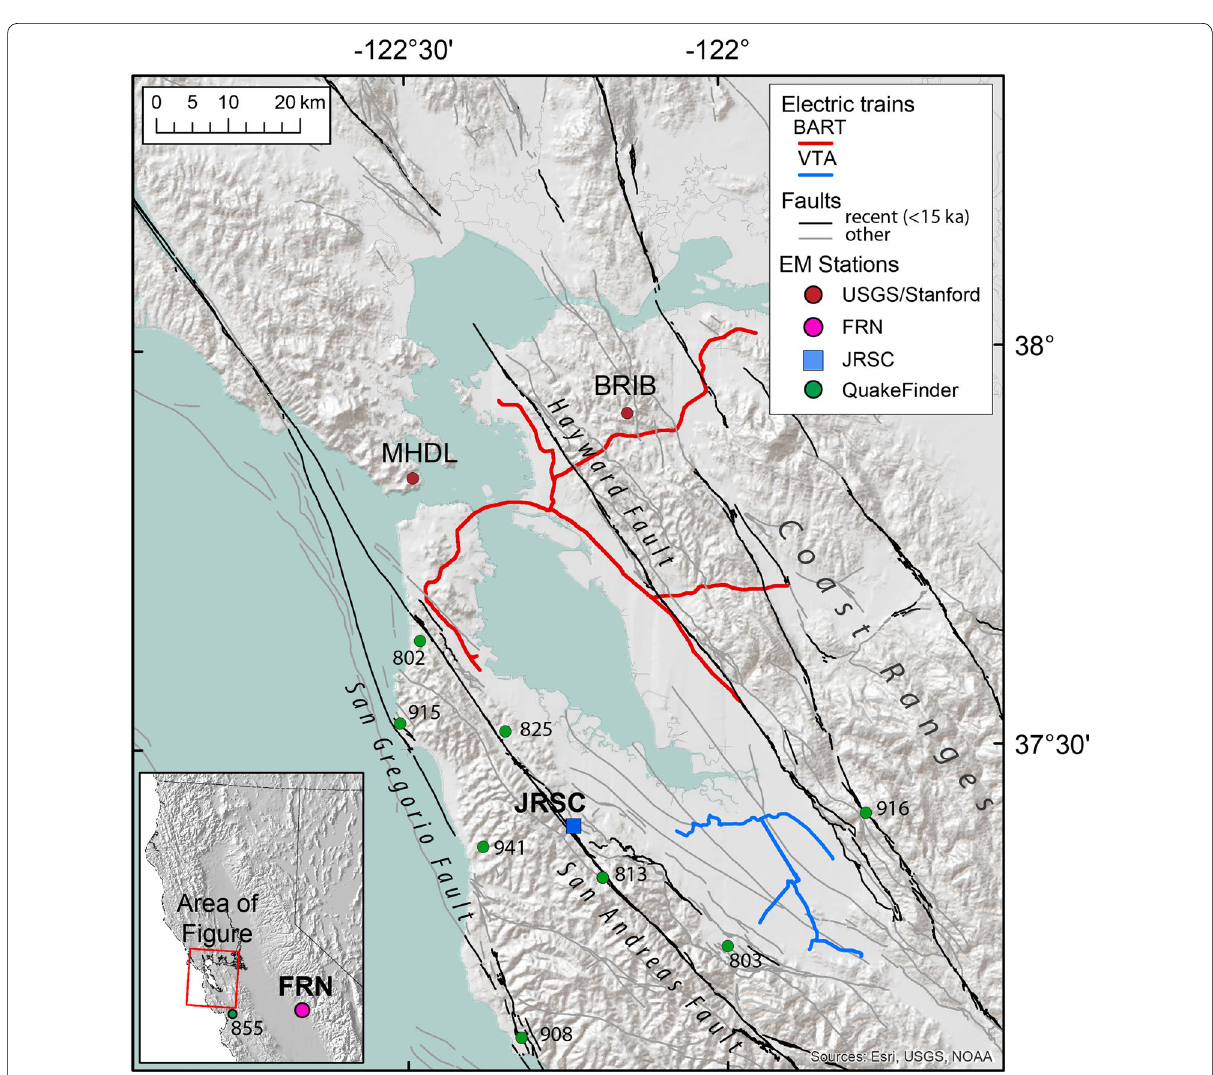
Fig. 1 Location map of the greater Bay Area, California (CA) with hill-shaded topography. Blue square: USGS-Stanford permanent electromagnetic observatory and QuakeFinder temporary magnetic systems at Jasper Ridge Biological Preserve (JRSC); pink circle: USGS Fresno (FRN) magnetic sta- tion (in inset); green circles: QuakeFinder permanent EM stations in San Francisco Bay Area; red circles: other USGS-Stanford EM stations MHDL and BRIB. Gray and black lines: faults. Red and blue lines: electric trains, respectively, BART tracks and VTA light